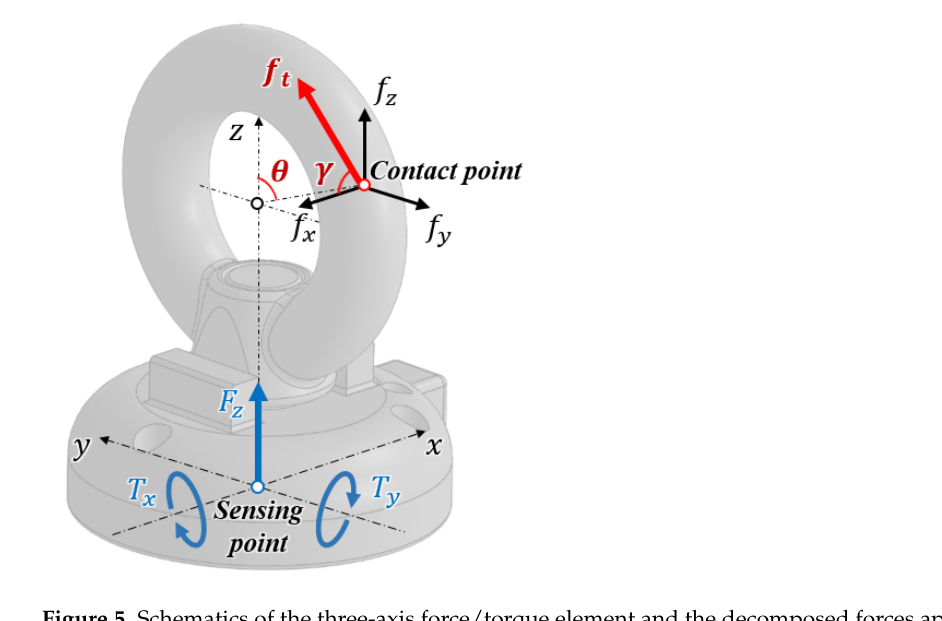
Figure 5. Schematics of the three-axis force/torque element and the decomposed forces applied to the sensor.